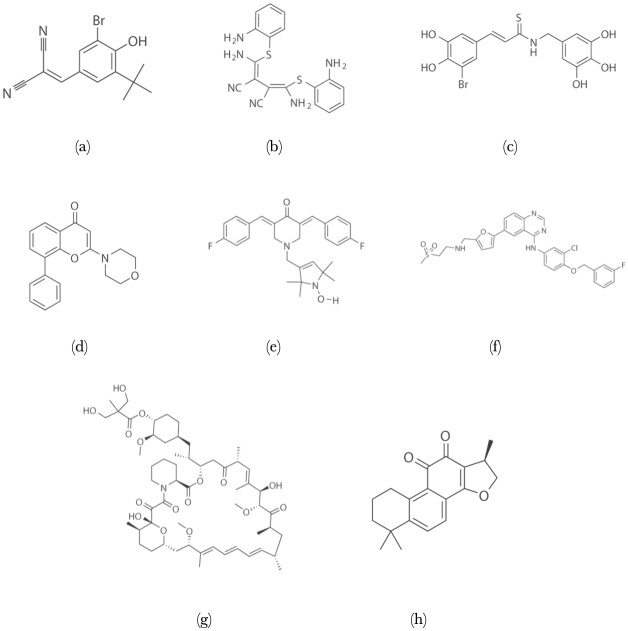
Chemical structures of the drugs: (a) AG1024 (b) U0126 (c) NT157 (d) LY294002 (e) HO-3867 (f) Lapatinib (g) Temsirolimus (h) Cryptotanshinone.